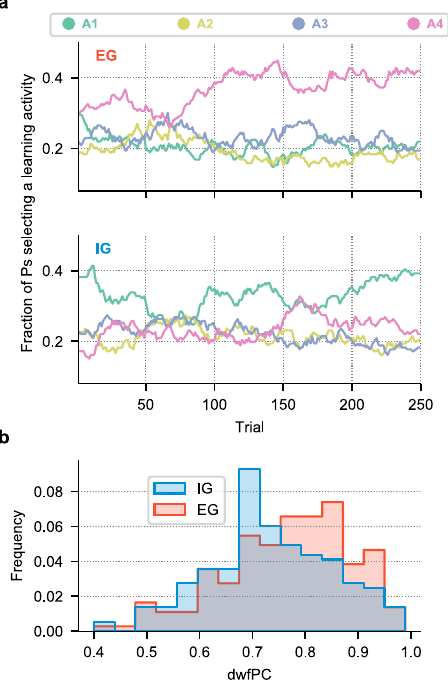
Fig. 2 Free play behavior. a The fraction of participants selecting each learning activity in the EG ( N = 196) and IG ( N = 186) groups (respectively, top and bottom panels) as a function of trial number during the free play stage (no smoothing) demonstrate that group differences in choice patterns persisted throughout the task. b Histograms of dif fi culty-weighted fi nal performance (dwfPC) for each instruction group. The EG group ( N = 196) achieved better dwfPC scores than the IG group ( N = 186), but the distributions were broad and overlapping, highlighting important individual variability. The difference between groups was signi fi cant with both dwfPC and unweighted average PC scores. Source data are provided as a Source Data fi